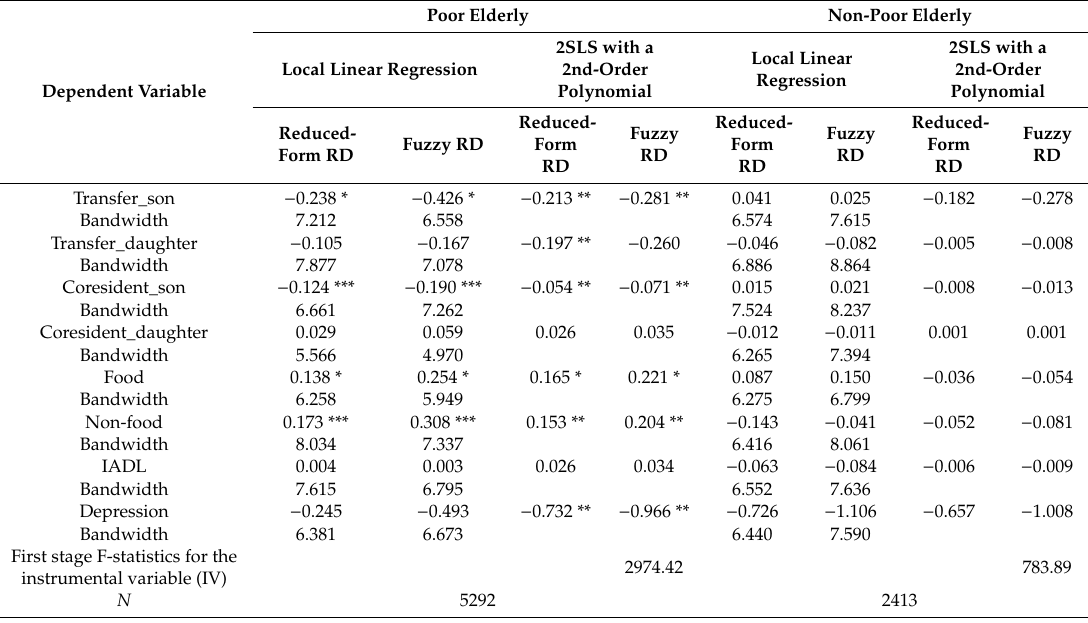
Table 4. RD estimation on outcomes of interest by poverty